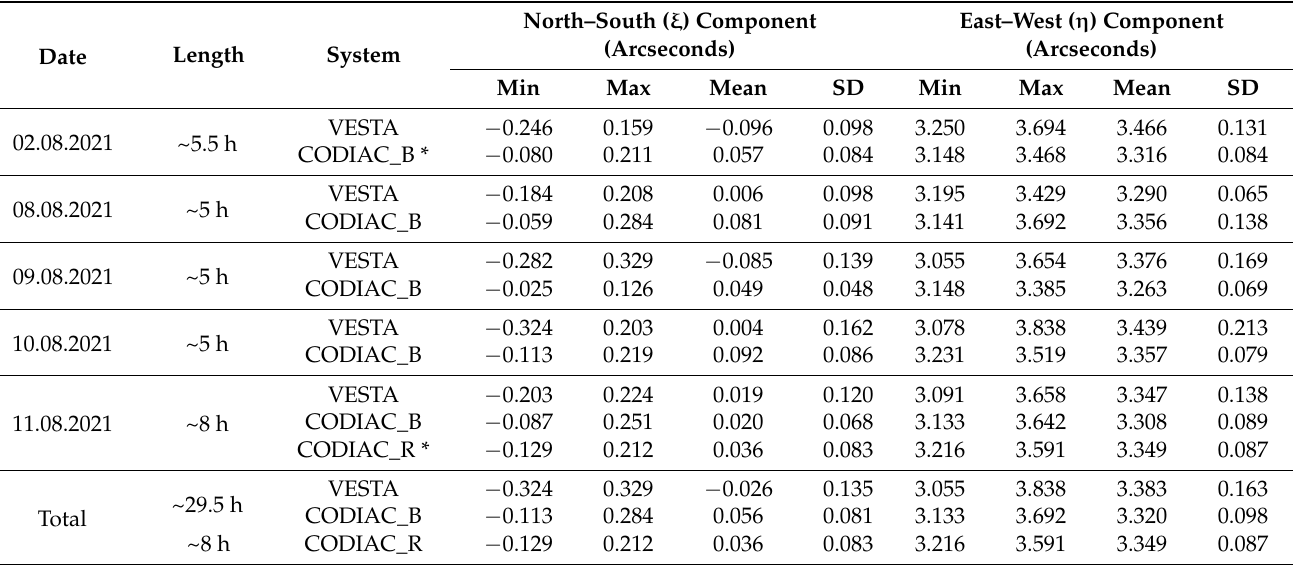
Table 3. Statistics of the nightly values for VESTA and CODIACs.